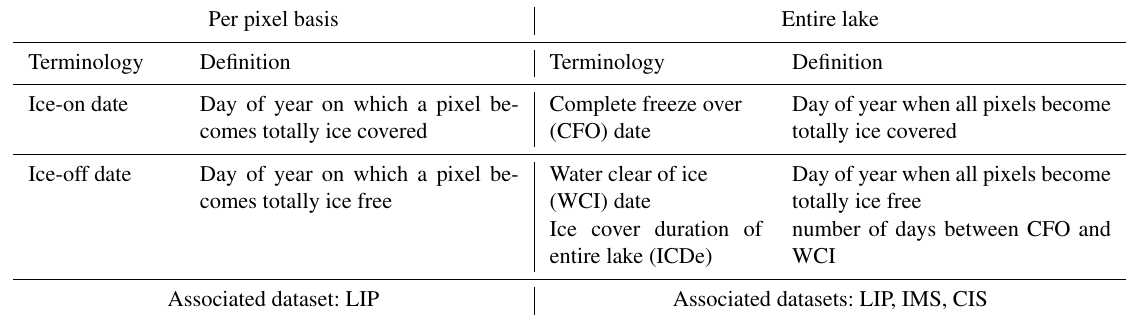
Table 1. Definitions of remotely sensed lake ice phenology variables from this study in relation to the other lake ice observational datasets used for the LIP validation assessment on a per pixel basis and for entire